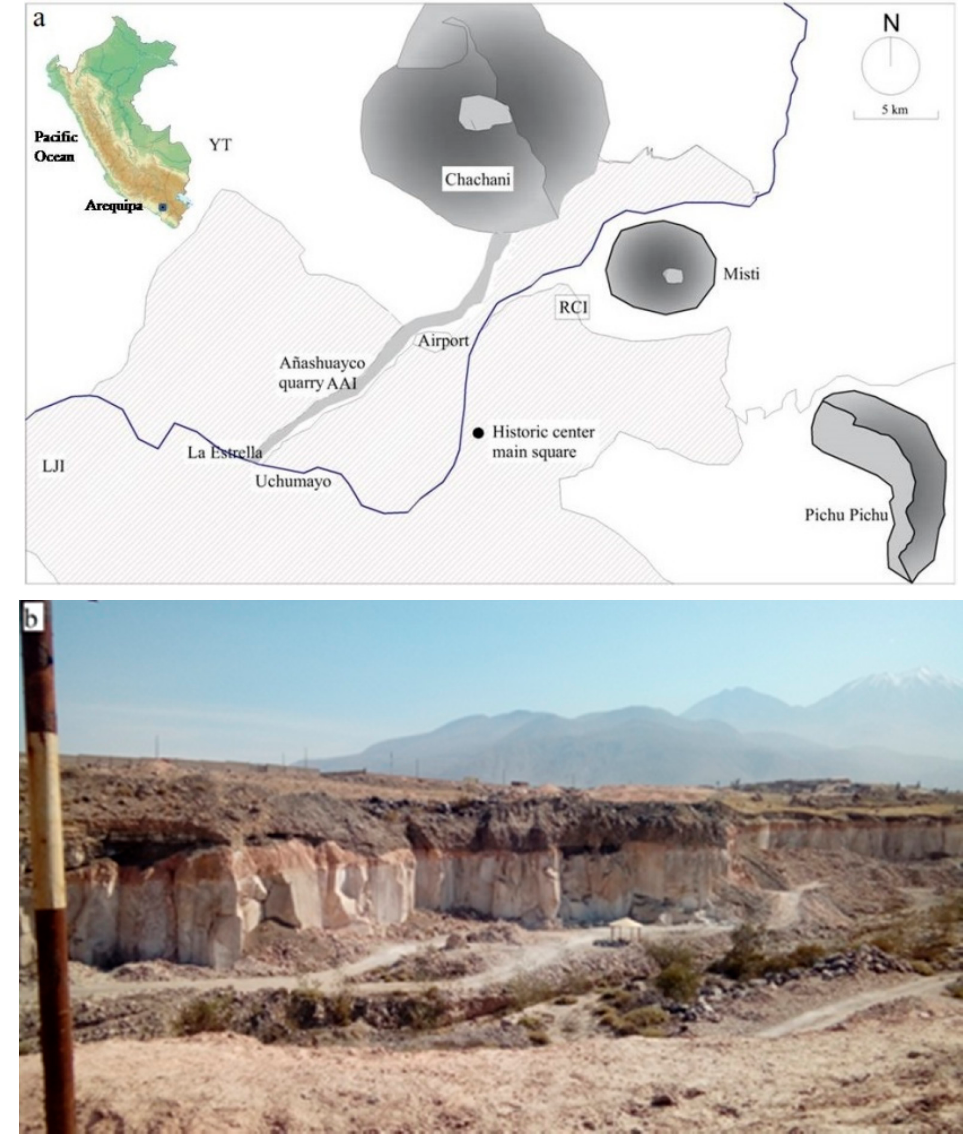
Figure 2. ( a ) Location. ( b ) Western front of Añashuayco quarry (Chachani volcano to the